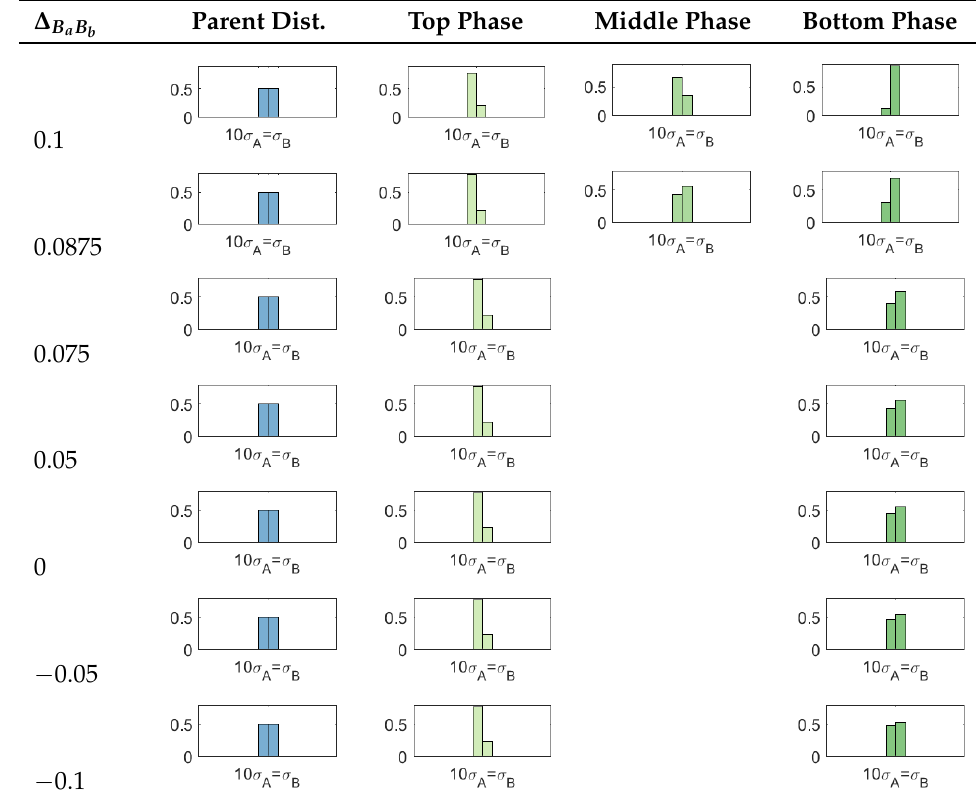
Table 2. Phase separation of different mixtures and fractionation of component B for a specific parent = 0.010, η = 0.200), depending on the nonadditivity of component B , see distribution ( η A B parent parent also Figure